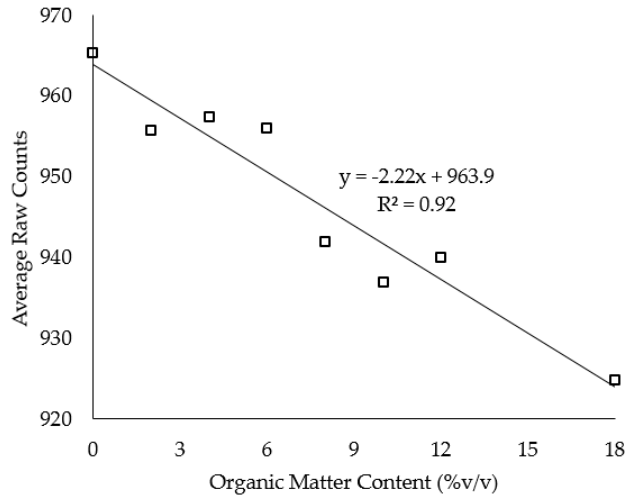
Figure 1. Correlation between organic matter level and average sensor readings ( n = 72).